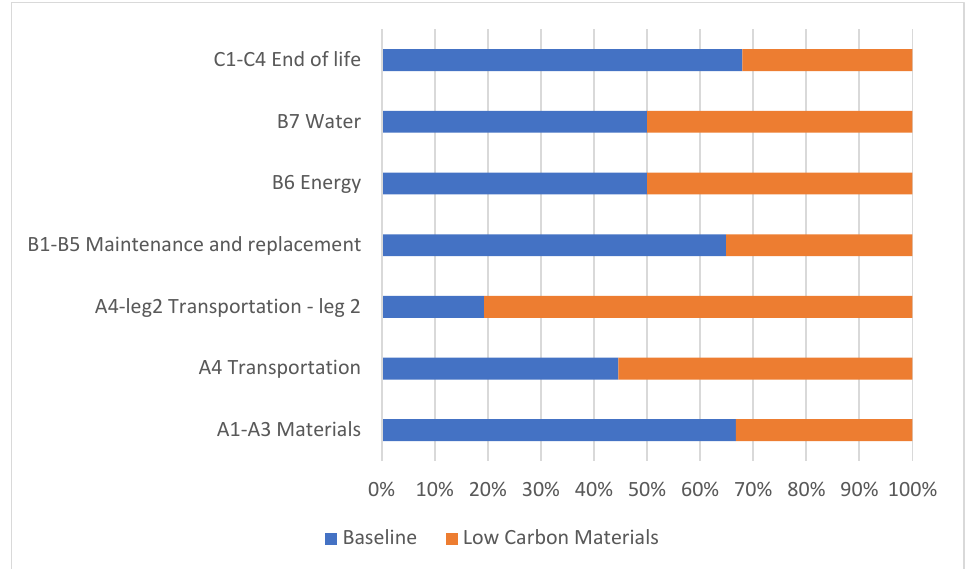
Figure 7. Comparison between baseline and low-carbon materials on the different life cycles.